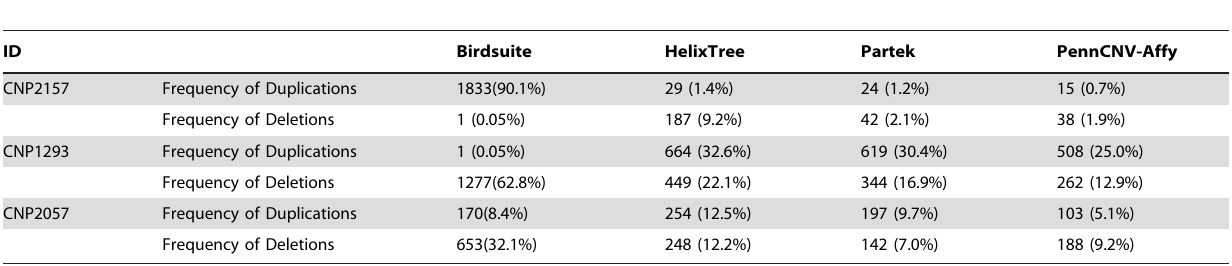
Table 7. Frequencies with which each program calls three common CNVs identified by Canary in the BiGS dataset.